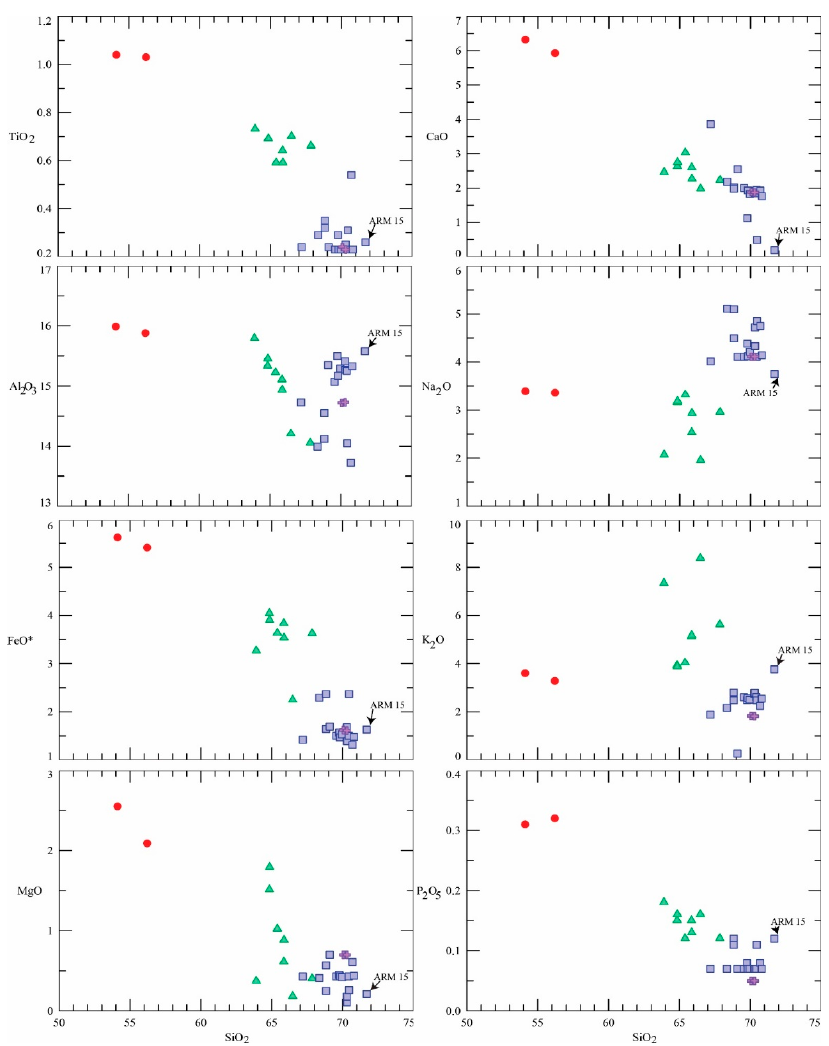
Figure 9. Diagrams of the variation of some oxides versus SiO 2 . See symbol legend in Figure 8.